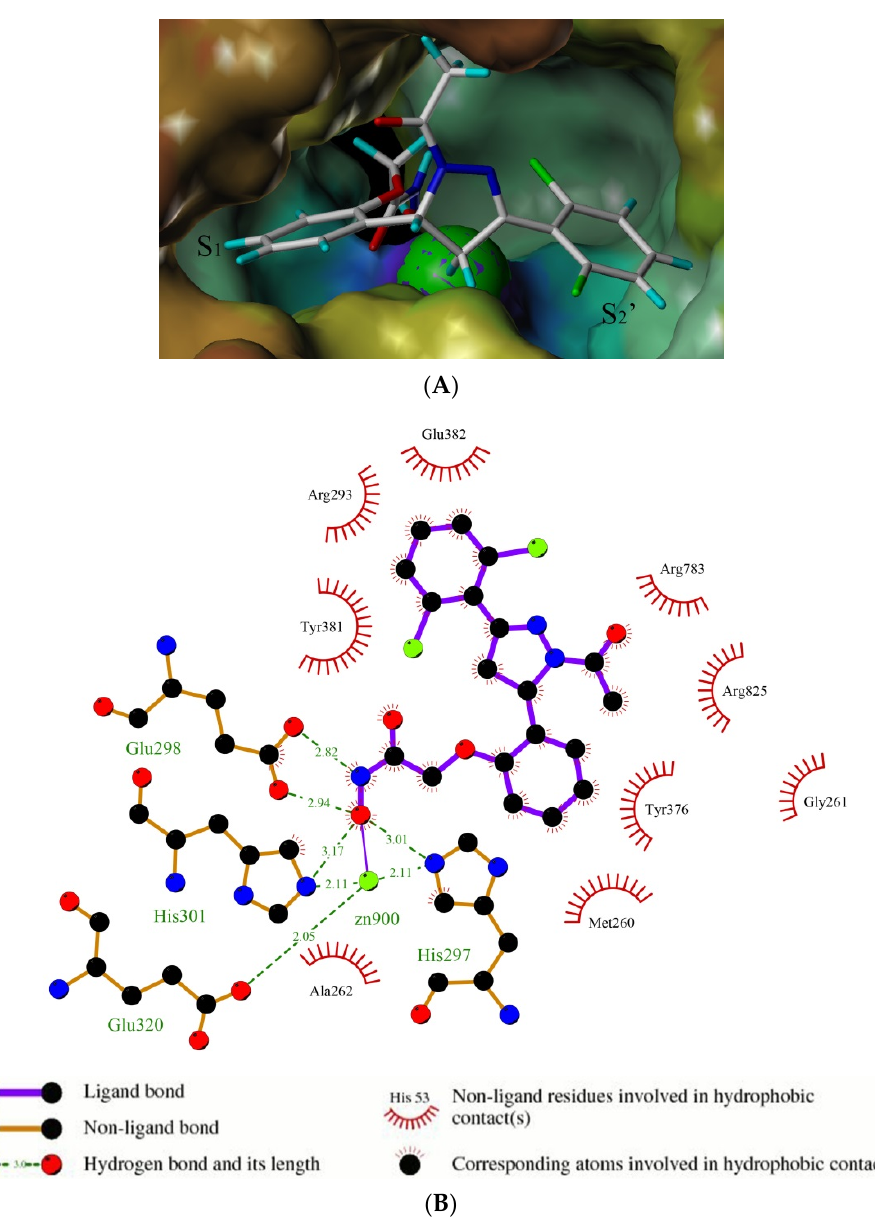
Figure 4. ( A ) The FlexX docking result of 14o in the active site of APN (PDB code: 2DQM). The carbon atoms are marked in gray, oxygen atoms in red, hydrogen atoms in light blue, nitrogen at- oms in blue and chlorine atoms in green. The green sphere represents zinc ion. S 1 and S 2 ′ represent two hydrophobic pockets. ( B ) The docking result shown by LIGPLOT. The carbon atoms, oxygen atoms, nitrogen atoms and chlorine atoms are marked in black, red, blue and green, respectively. The backbone of compound 14o is labeled violet and the zinc ion is shown as green sphere. The hydrogen bonds are shown as dashed lines (distance in Å).